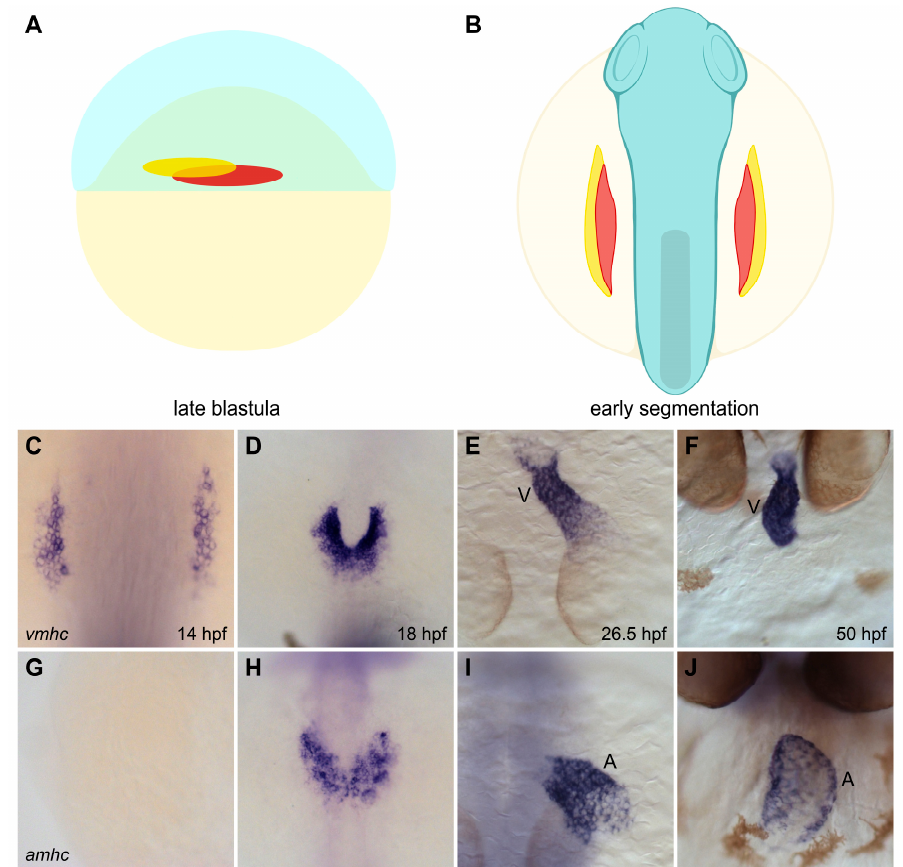
Figure 2. Spatial organization of ventricular and atrial myocardial lineages in the zebrafish embryo. ( A , B ) Cartoons illustrate the locations of the territories containing ventricular (red) and atrial (yellow) myocardial progenitor cells in the early embryo. Lateral view of the late blastula ( A ) shows that the regions containing ventricular and atrial myocardial progenitors are spatially organized prior to gastrulation [34]. Dorsal view of the gastrula ( B ) shows the ALPM regions that contain ventricular and atrial myocardial precursors during early segmentation stages [28]. ( C – J ) In situ hybridization depicts the expression patterns of vmhc ( C – E , dorsal views; F , frontal view) and amhc ( G – I , dorsal views; J , frontal view), indicating the relative positions of ventricular and atrial cardiomyocytes as they differentiate and form the heart. Ventricular cardiomyocytes initiate vmhc expression around 14 hpf ( C ), whereas atrial cardiomyocytes initiate amhc expression around 18 hpf ( H ) [38,39]; at these stages, ventricular cardiomyocytes are located more medially than atrial cardiomyocytes ( D , H ). Ventricular and atrial cardiomyocytes go on to occupy separate portions of the heart tube ( E , I ); later, the ventricular and atrial chambers become morphologically distinct ( F , J ). V, ventricle, A, atrium. Images adapted from [27]; illustrations by Jessyka T. Diaz.